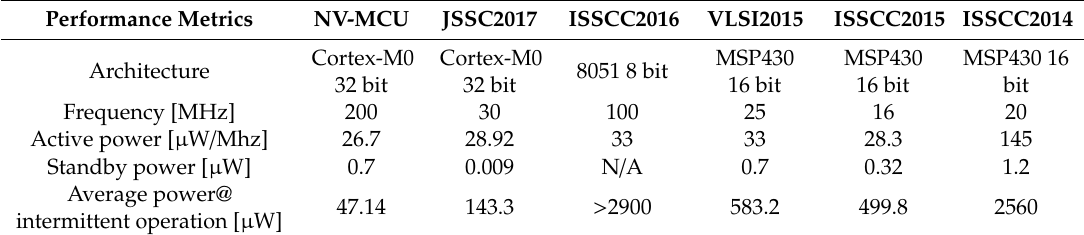
Table 2. Comparison of average power consumption for microcontroller units